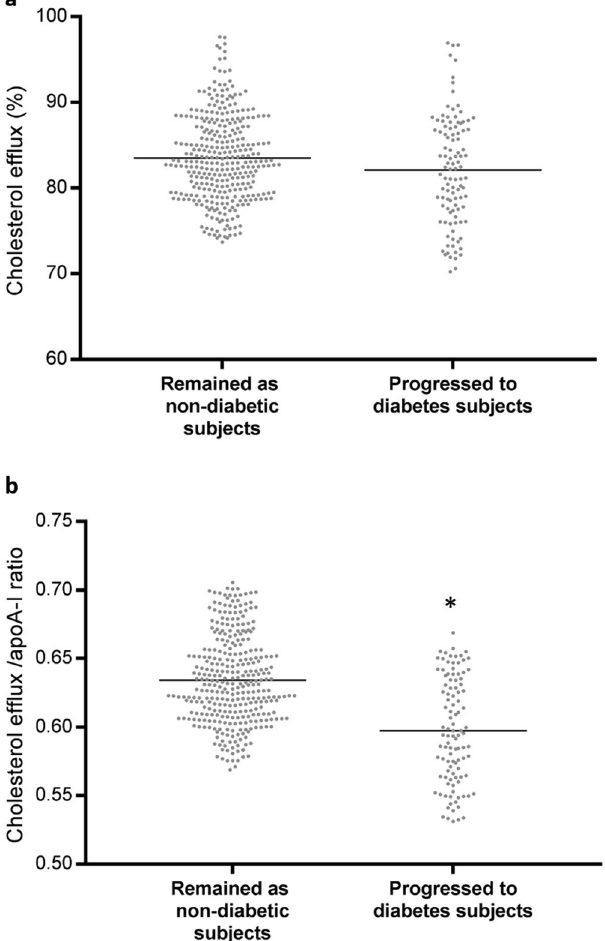
Figure 1. Cholesterol efflux and cholesterol efflux/apoA-I ratio by glycaemic status at the end of the follow-up period. Scatterplot showed raw data of cholesterol efflux in % ( a ) and cholesterol efflux normalised by apoA-I ( b ) in subjects who remained as non-diabetic and subjects that progressed to diabetes. Black bars indicated mean values in each group. * p < 0.005 between groups analysed by univariate model adjusted by age, sex BMI and batch